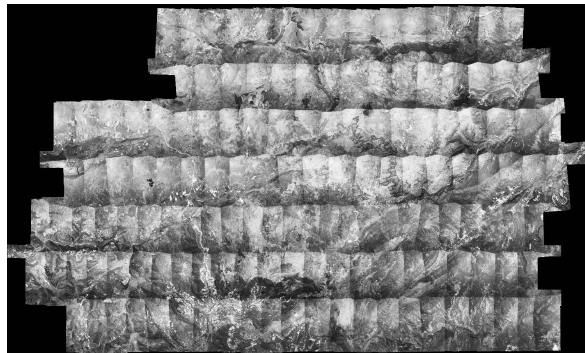
Figure 1a: Orthophotomosaic with overlaps Figure 1b: Orthophotomosaic with Voronoi